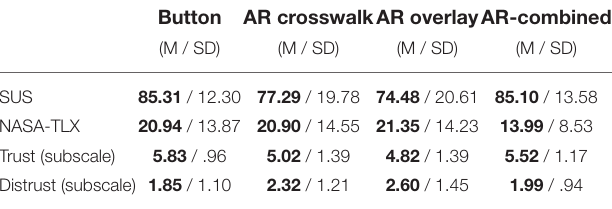
TABLE 2 | Mean (M) and standard deviation (SD) for NASA-TLX scores, SUS scores, and Trust Scale ratings. Button AR crosswalkAR